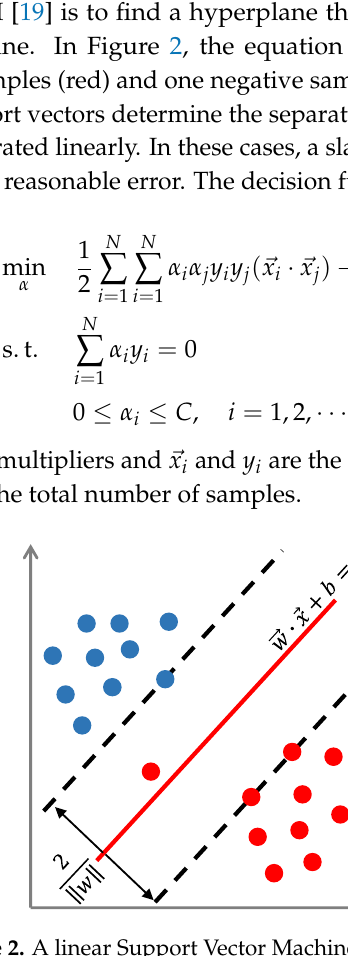
Figure 2. A linear Support Vector Machine (SVM)